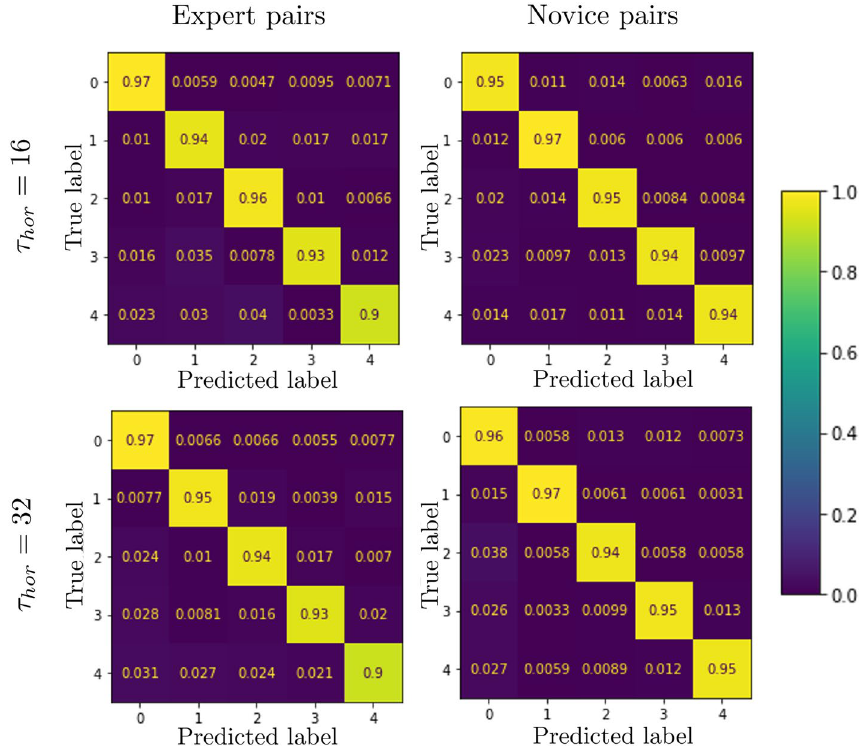
Figure 2. Confusion matrices for the trained prediction models tested on 10 sets of N test = 2000 samples for each expertise level and prediction horizon. Values on the diagonal indicate the portion of test samples correctly predicted.